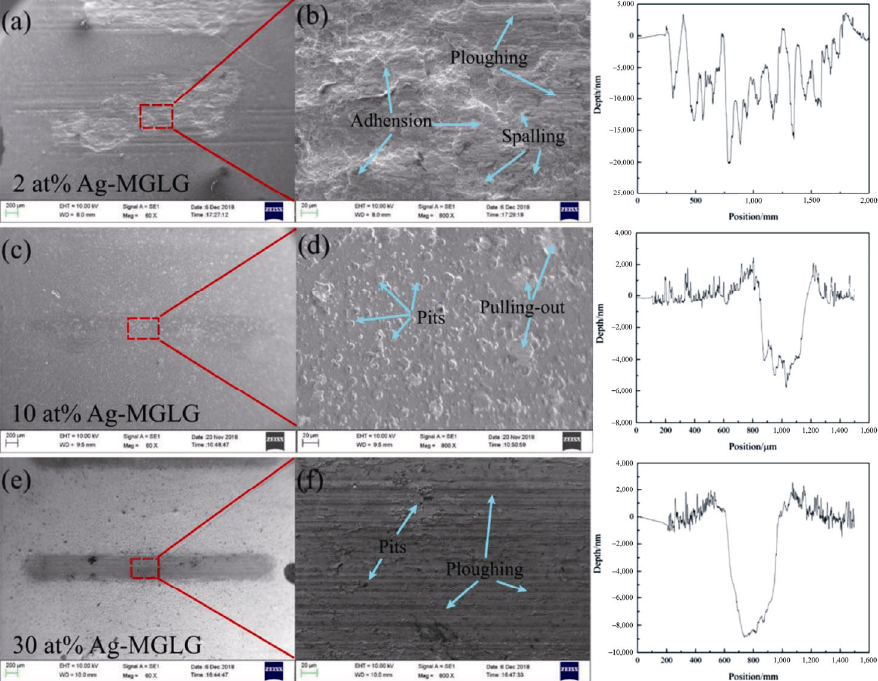
Fig. 7 SEM morphologies of (a) worn surfaces and (b) TiN–Ag coatings with 2 at% Ag content; (c, d) TiN–Ag coatings with 10 at%